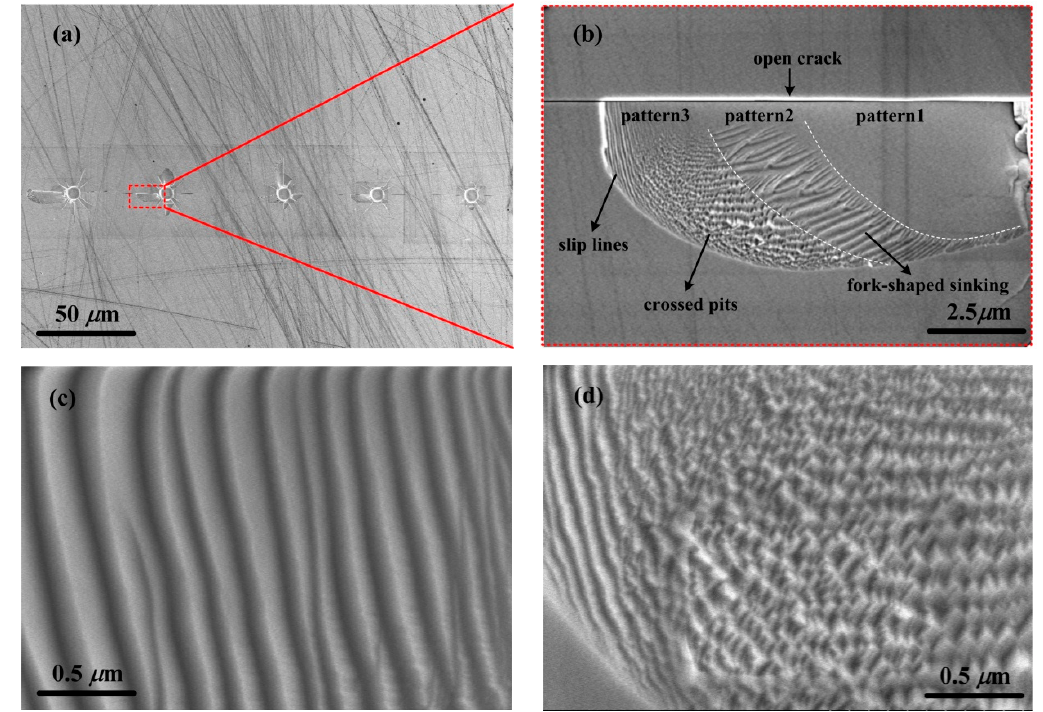
Figure 6. ( a ) SEM image of the five imprints after flat-tip indention of 400 mN. ( b ) Enlarged image of the wing-shaped sinking region along the open crack. The dashed curves indicate the boundary of three distinct surface material sinking patterns, named as “pattern1”, “pattern2”, and “pattern3”. ( c , d ) are the enlarged images of the slip lines and crossed pits marked in ( b ).